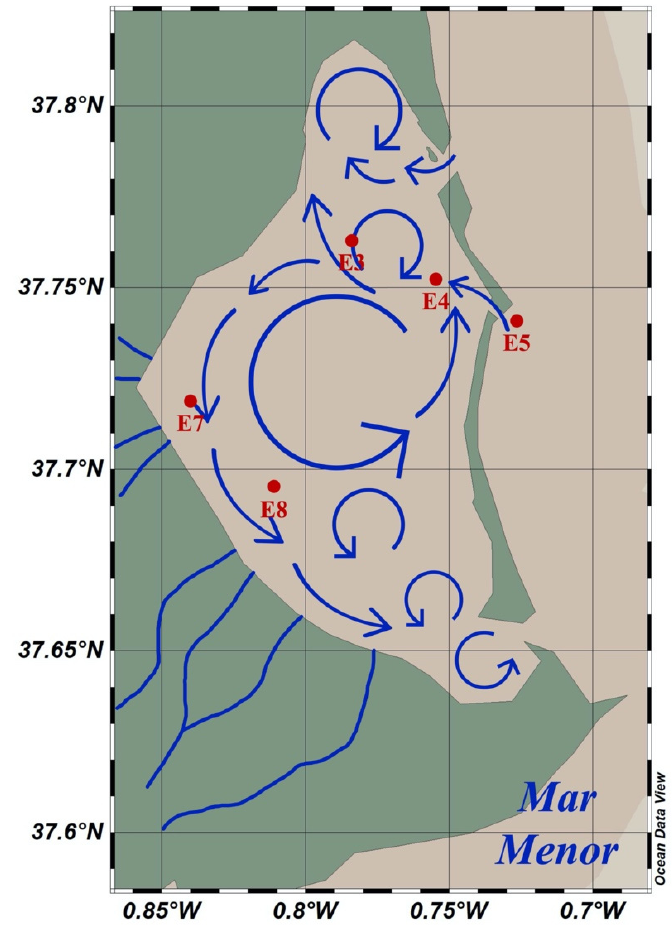
Figure 9. Current patterns, inflow watercourses, and canals connecting the Mar Menor to the Mediterranean Sea. Designed in accordance with Pérez-Ruzafa et al., 2005 [13], García-Oliva et al., 2018 [35], and Fernández-Alías et al., 2020 [36].